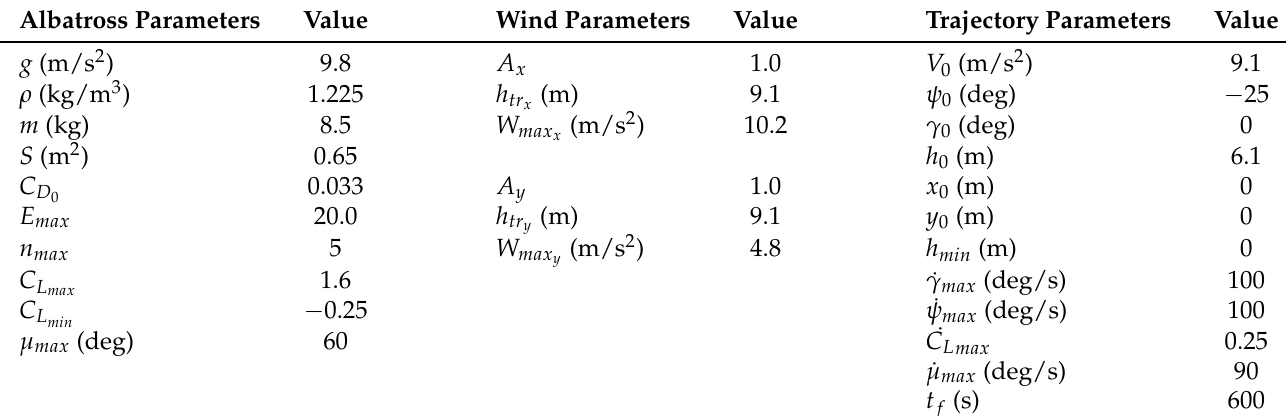
Table 1. Albatross neurocontroller simulation parameters.